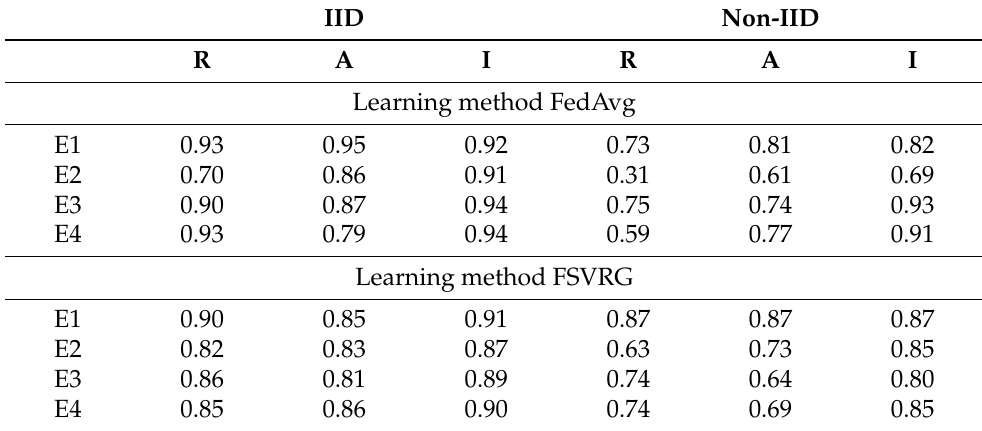
Table 9. Classification accuracies for dataset HAR.